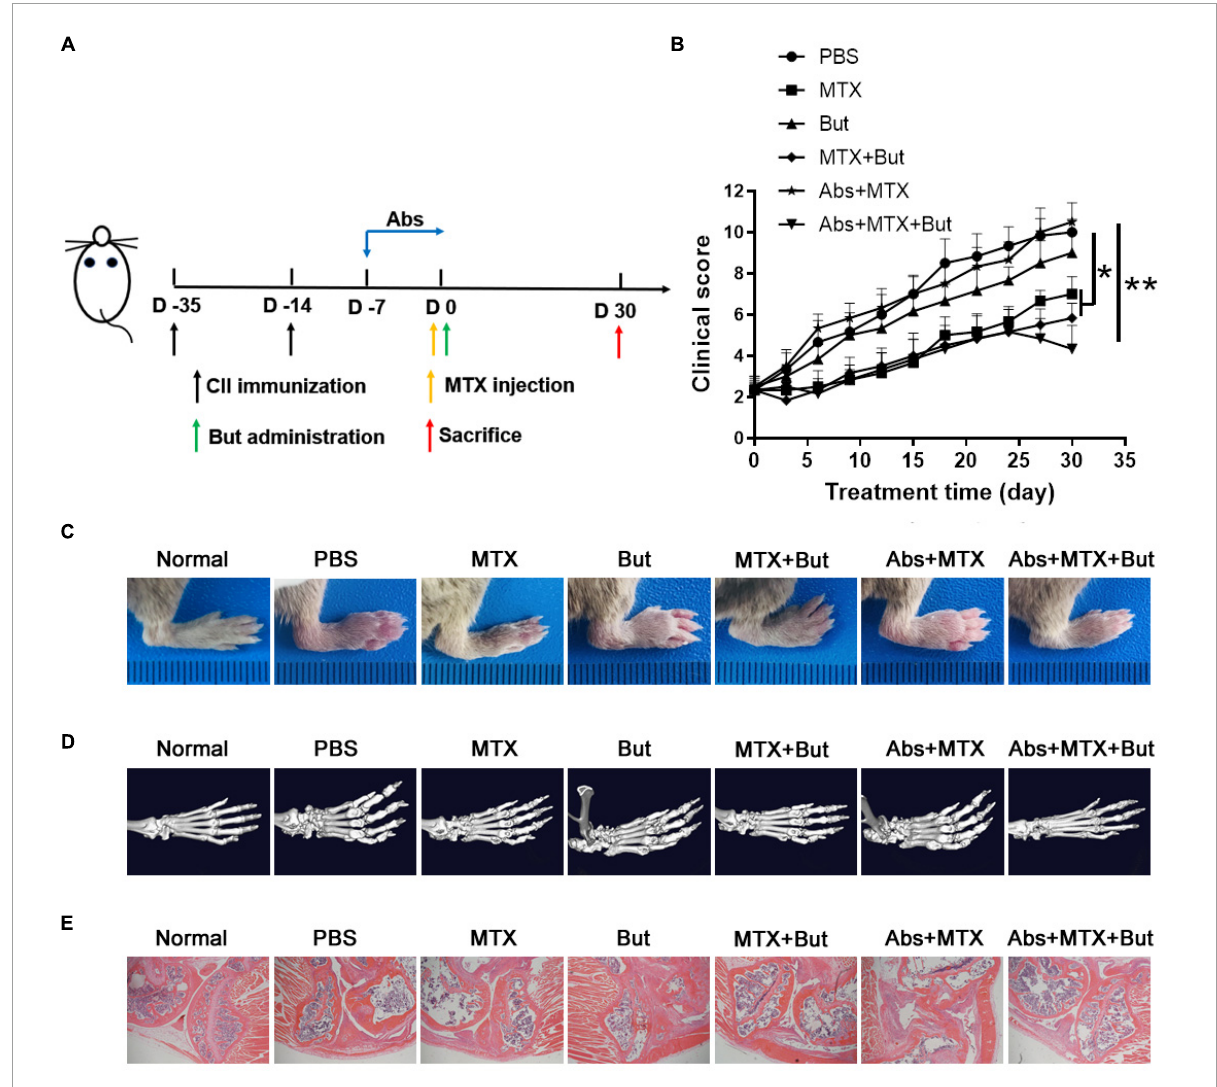
FIGURE5 Butyrate improves the efficacy of MTX in gut microbiota-deficient mice. (A) Schematic of treatments. Mice were treated with antibiotics at the onset of arthritis. Mice received butyrate administration and MTX injection on day 0. (B) Clinical scores of CIA mice (n = 6). (C) The photos of hindlimb. (D) Micro-CT assessment of paws. (E) HE staining of joint tissues (magnification is 40 × ). Data are presented as the mean ± SEM. * p < 0.05, ** p < 0.01. Abs, antibiotics; But,